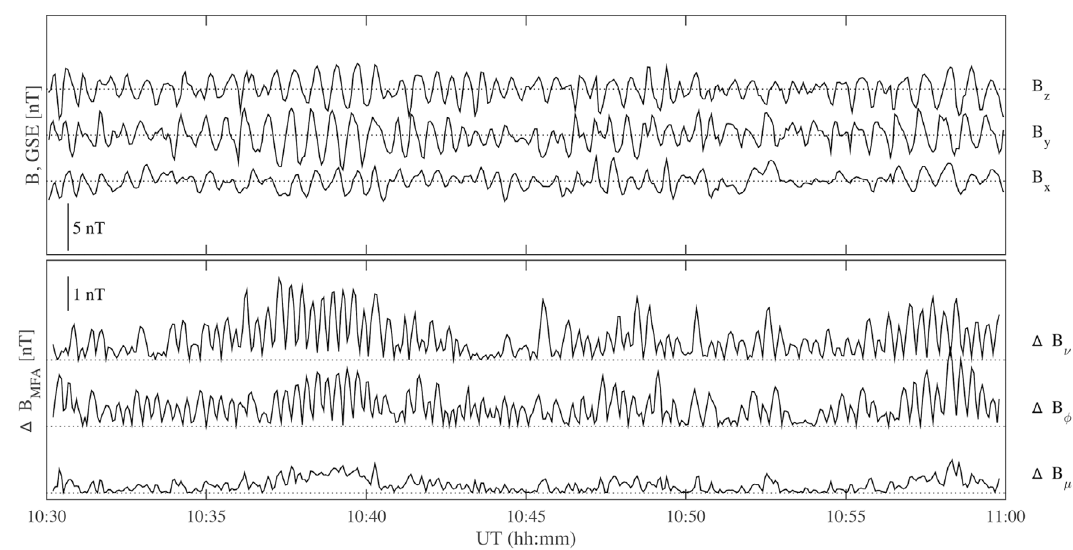
Figure 10. Upstream wave event observed by Cluster-1 satellite on May 6, 2005. Top panel: original magnetic field components in the GSE reference frame. Bottom panel: the absolute value of the differences between homologous MFA components obtained by means of MAVG and EMD methods. During this time interval Cluster-1 was at the position (6.5,-16.9,-7.2) Re (1 Re = 6380 km), and average magnetic field 〉 = (−4.8,−0.2, 2.1) nT. In each panel, the zero levels are marked by horizontal dotted 〈 B 0